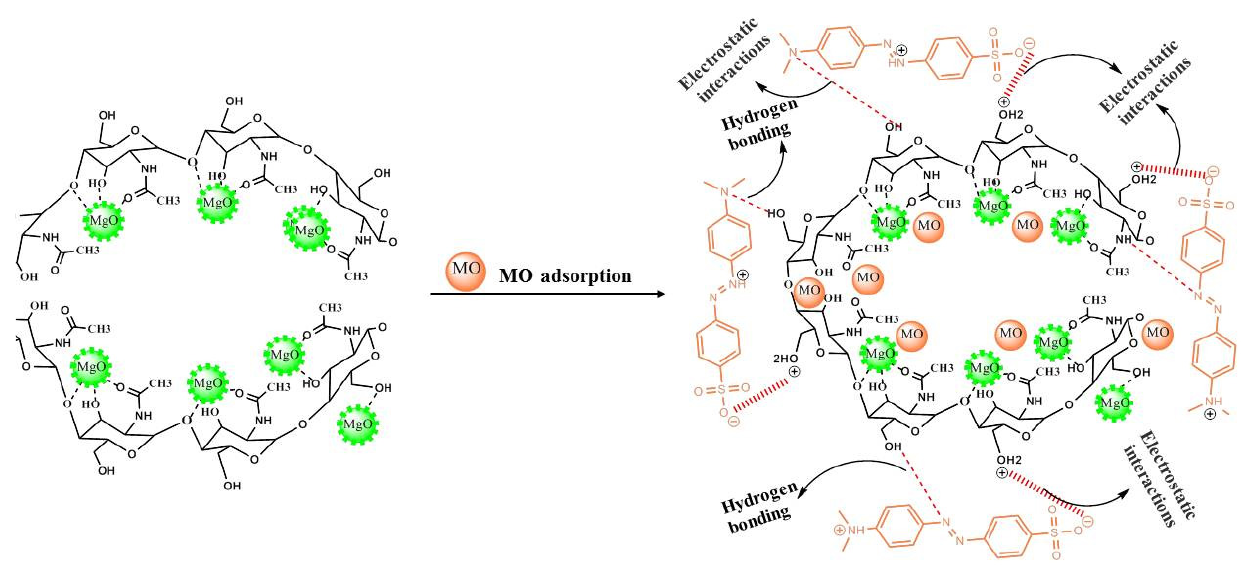
Figure 5. MO adsorption mechanism on